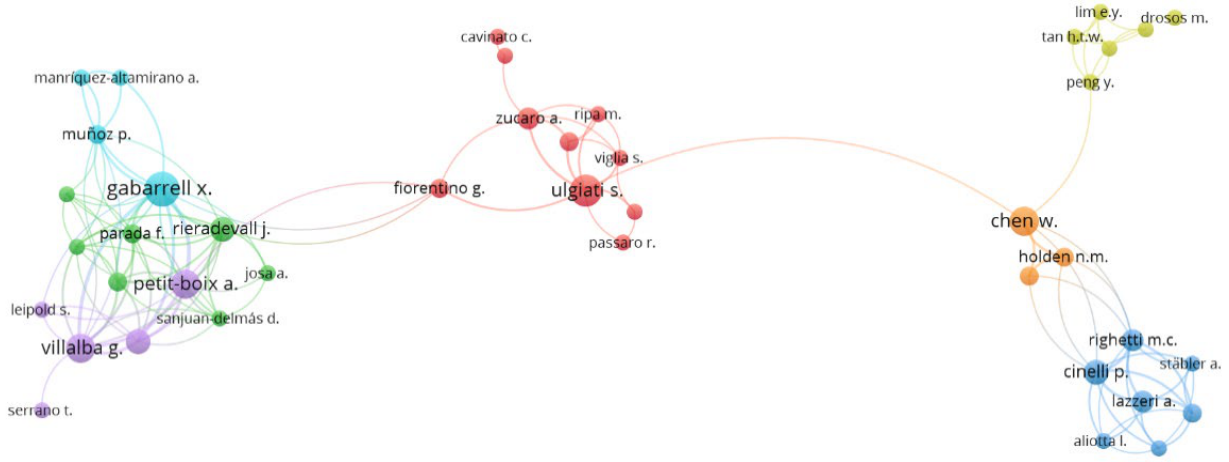
Figure 4. Network of cooperation based on co-authorship of the main authors (2005–2021).